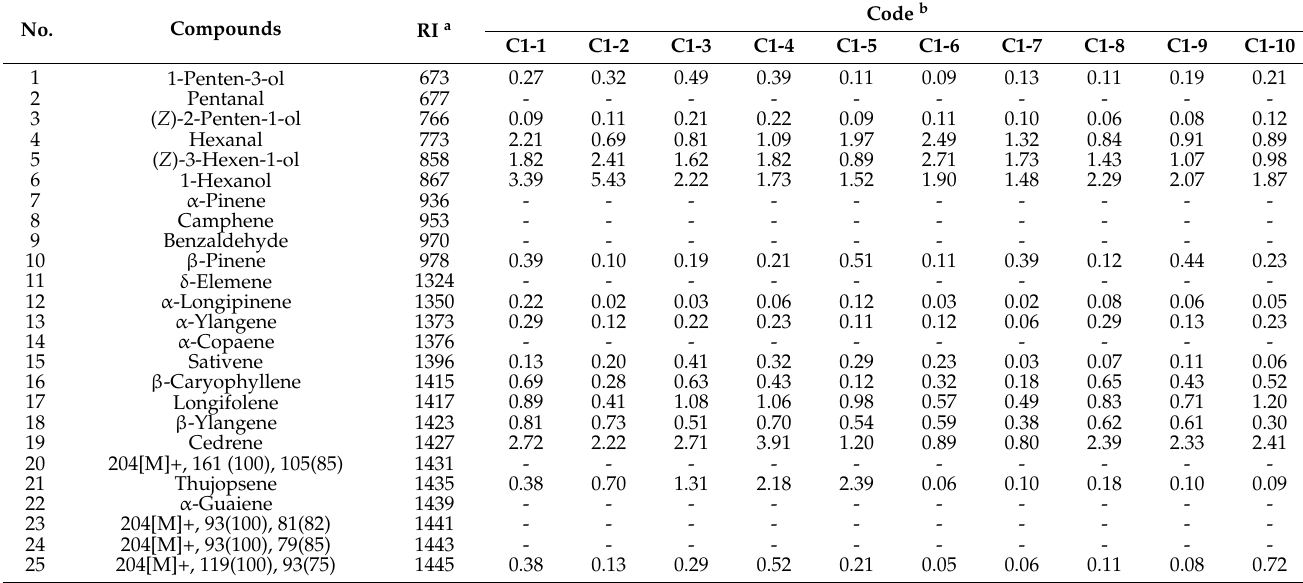
Table 2. Volatile compounds detected in the analyzed samples of genetic lineage C1 of the A.